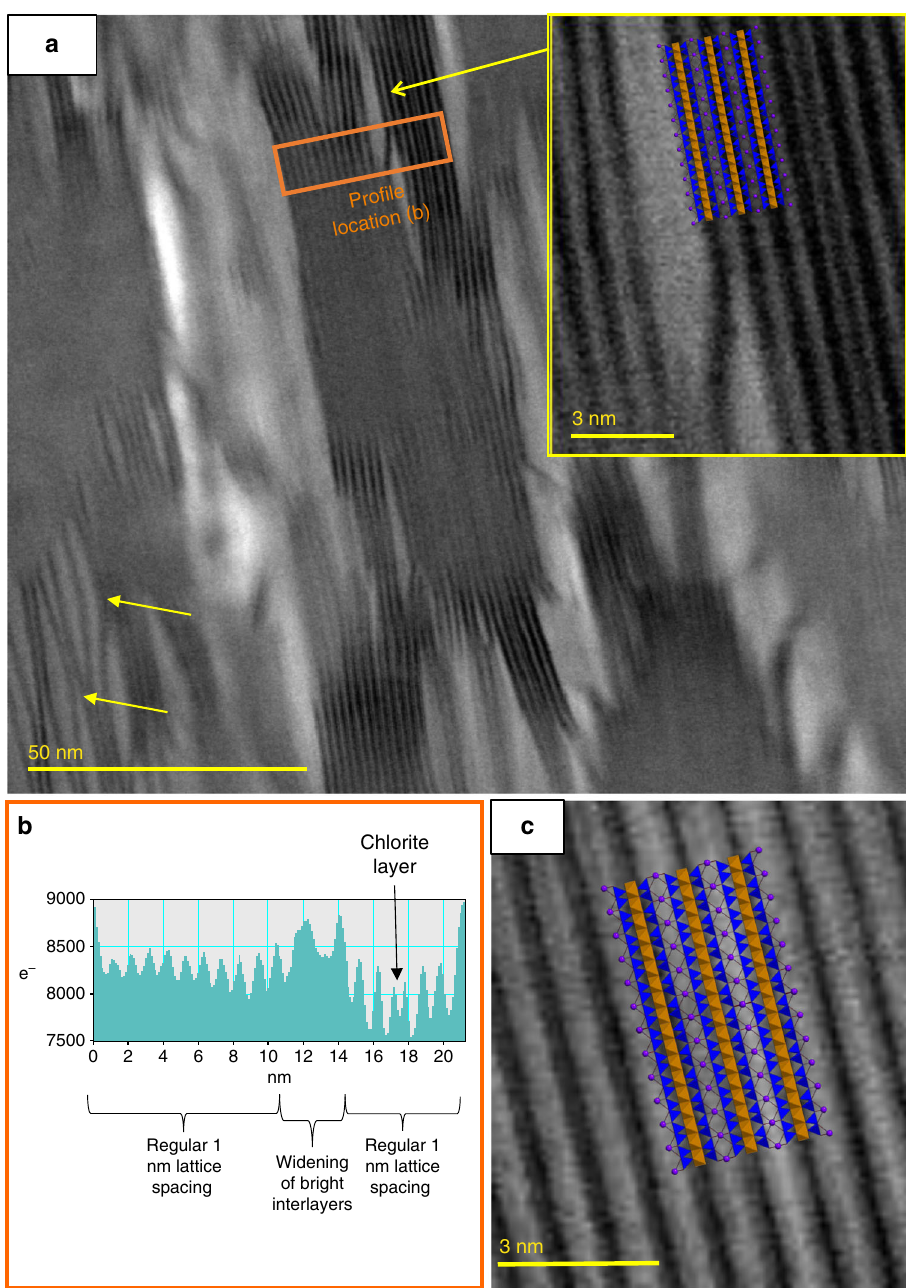
Fig. 3 Lattice curvature and interlayer expansion. a Lattice curvature is visible at the scale of individual TMT layers, which bend up to 30° within as little as 3 nm forming ripples (indicated by arrows in bottom left). Inset shows detail of the region indicated by the attached arrow overlain with a biotite atomic structure model showing how the lattice expansion occurs within the interlayer. b Pro fi le integrated from the region de fi ned in a showing a widening of brighter contrast interlayers within the regular 1 nm lattice spacing of pristine biotite. The double peak to the right represents an individual chlorite layer. c High-magni fi cation transmission electron microscope lattice fringe image with biotite atomic structure model overlain. Dark regions centre on octahedral layers, intermediate (grey) regions show tetrahedral layers and light regions demonstrate the location of